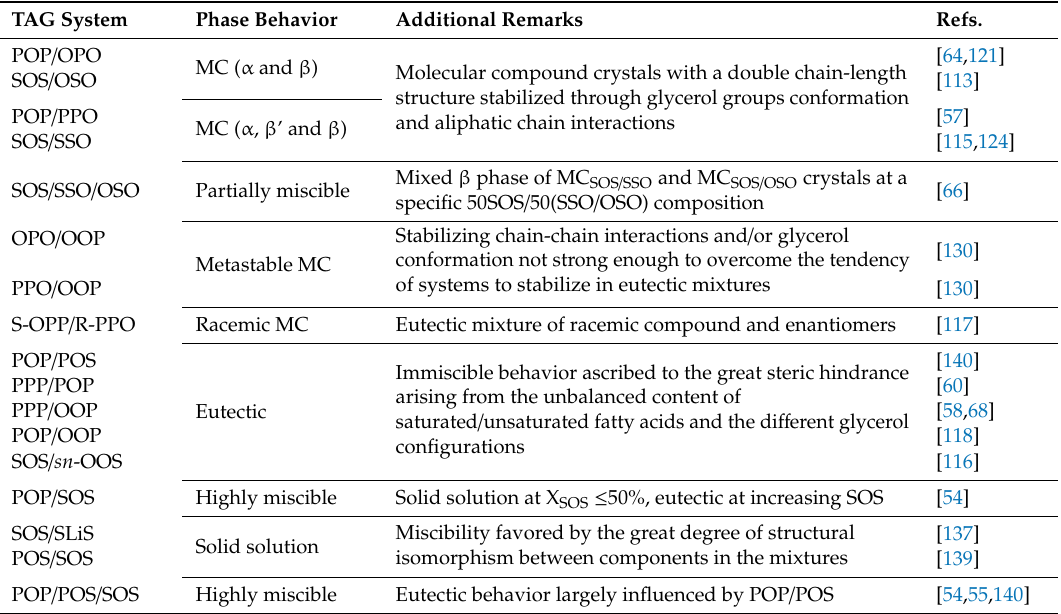
Table 5. Phase behavior in binary mixtures of saturated- cis -unsaturated mixed-acid TAGs. TAG